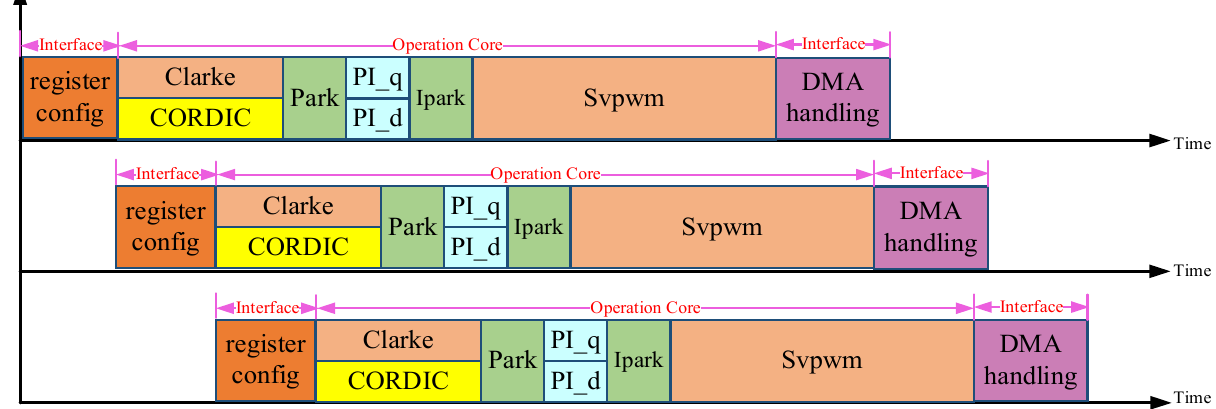
Figure 14. Coprocessor IP control timing sequence.